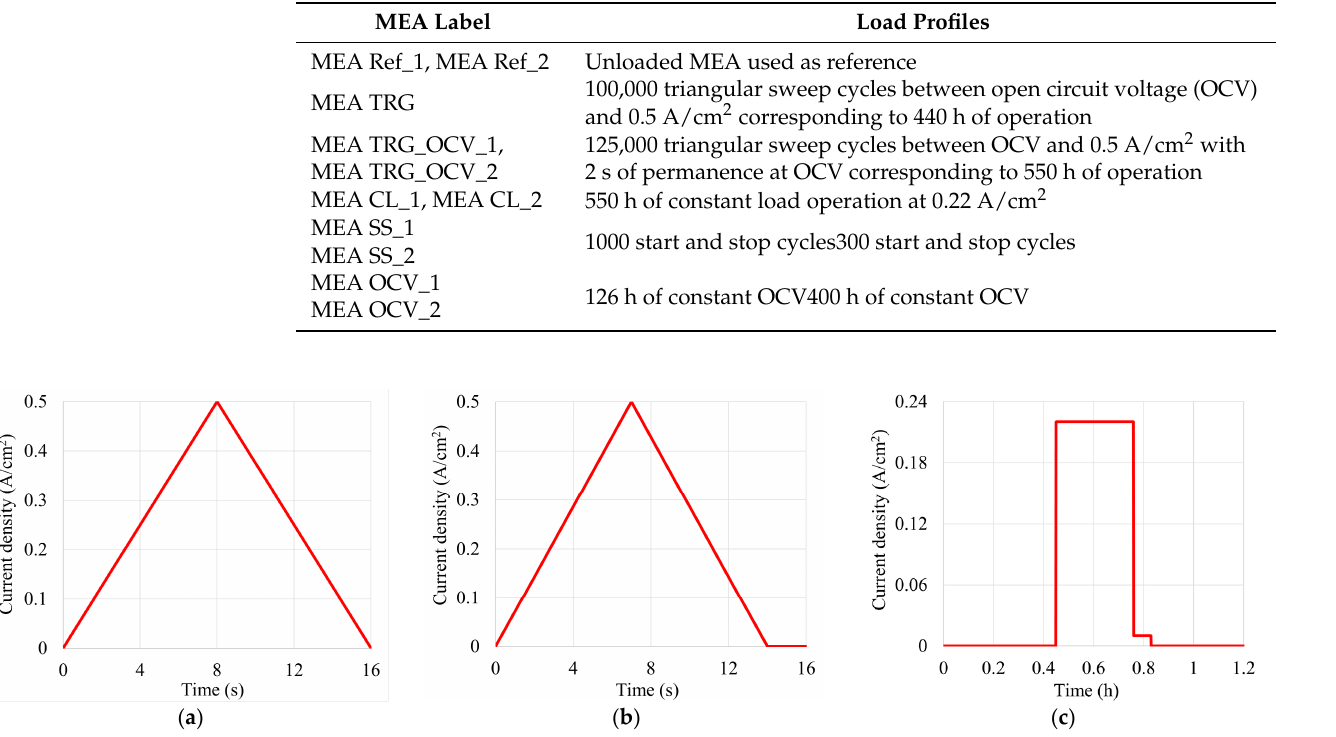
Figure 2. Load profiles: ( a ) triangular sweep cycles, ( b ) triangular sweep cycles with 2 s permanence at OCV and ( c ) Start and Stop cycles.